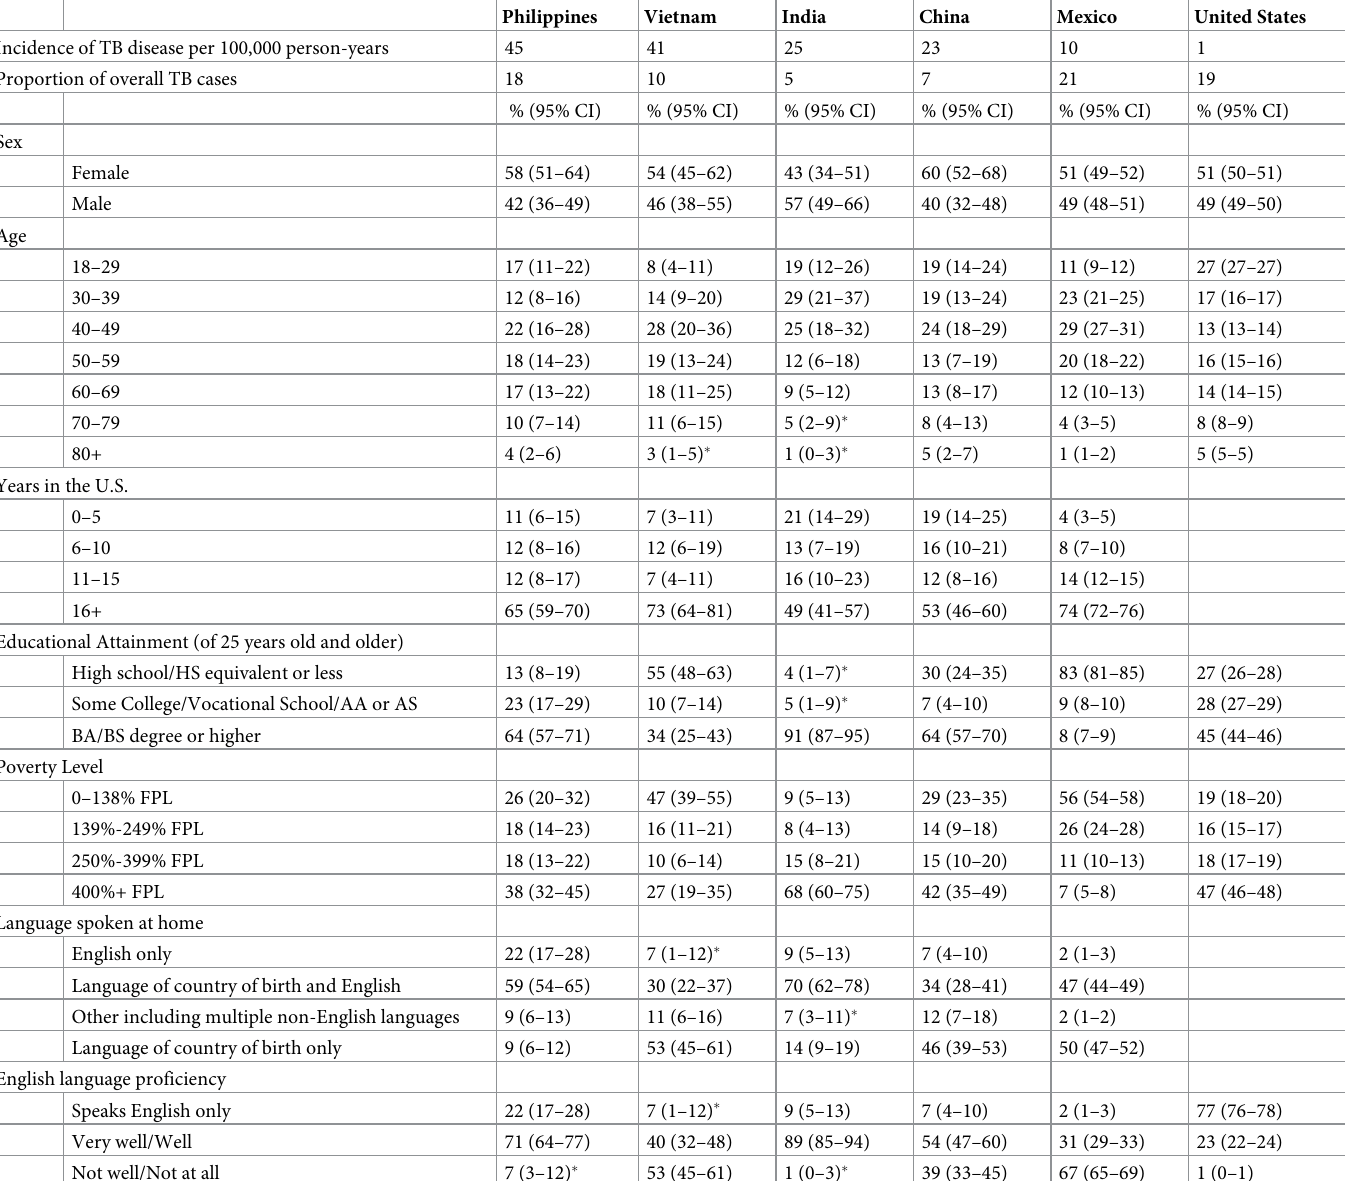
Table 1. TB Burden and demographic characteristics by country of birth, California